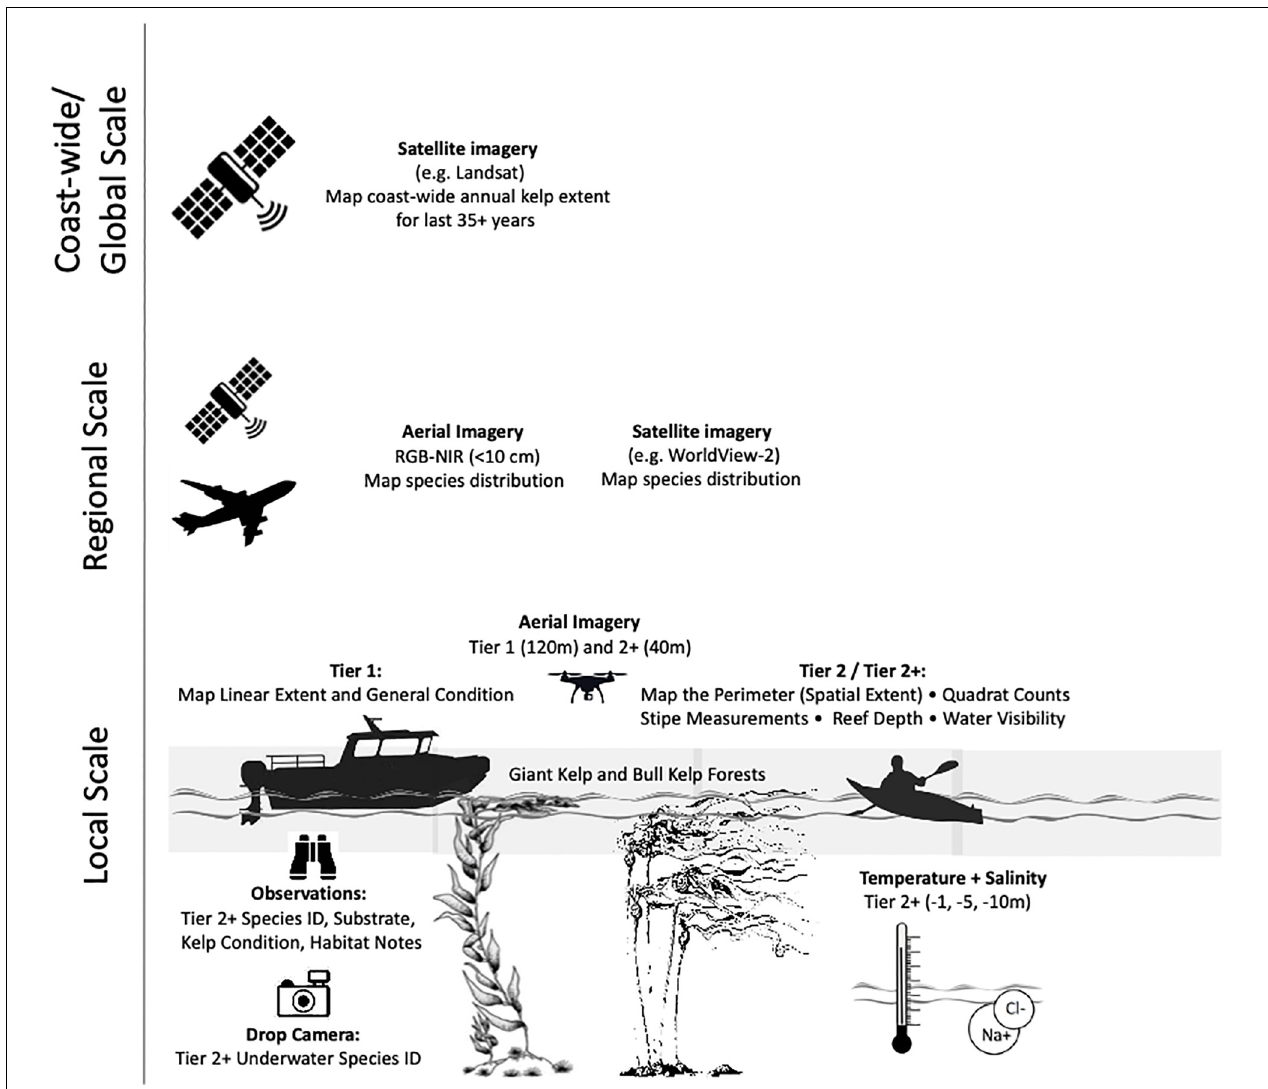
FIGURE 3 | Multi-scale canopy kelp monitoring approach taken by the Marine Plan Partnership. Local scale observations are separated into Tiers which represent increasing complexity of